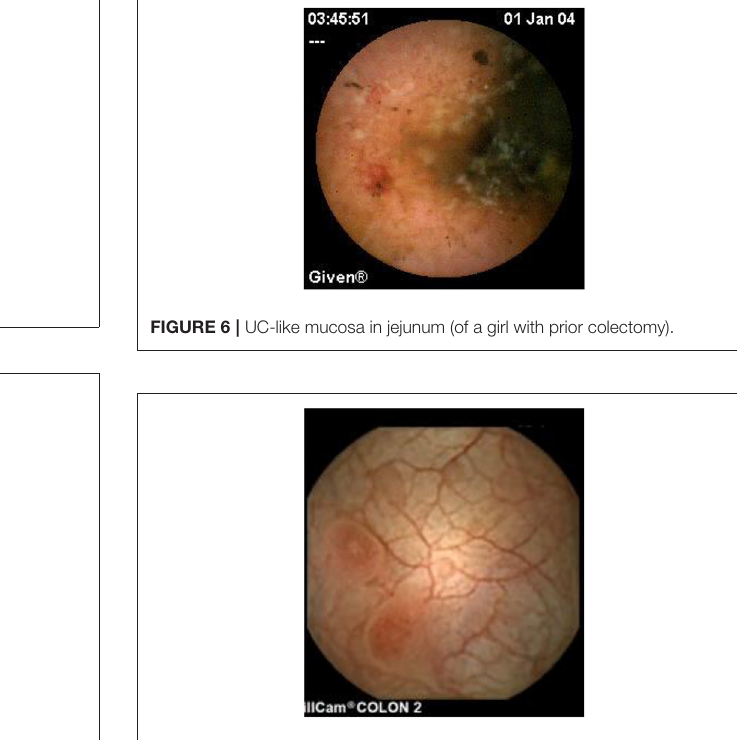
FIGURE 7 | Apthous ulcers in the